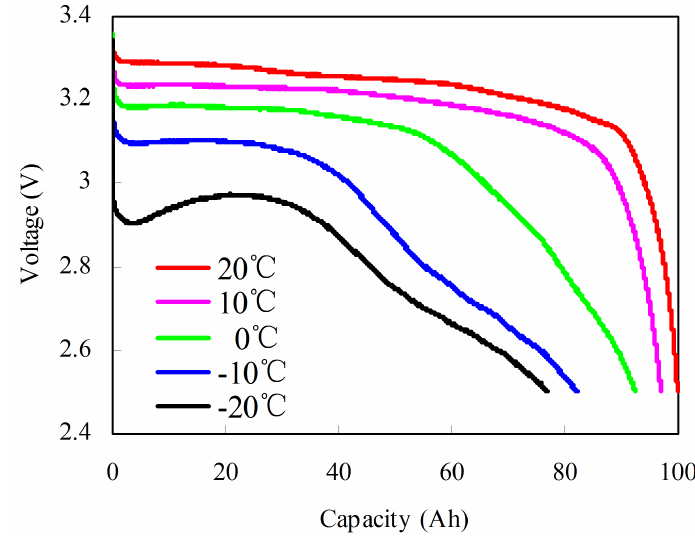
Figure 2. Discharge voltage curves at different temperatures.